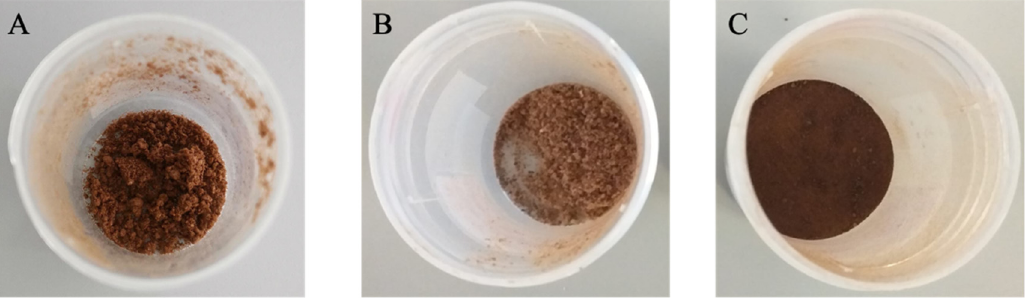
Figure 3. Color of the different freeze-dried extracts. ( A ) S_LS (laboratorial scale) freeze-dried extract; ( B ) S_PS (pilot scale) freeze-dried extract; ( C ) S_PS_C (pilot scale; concentrated) freeze-dried extract.